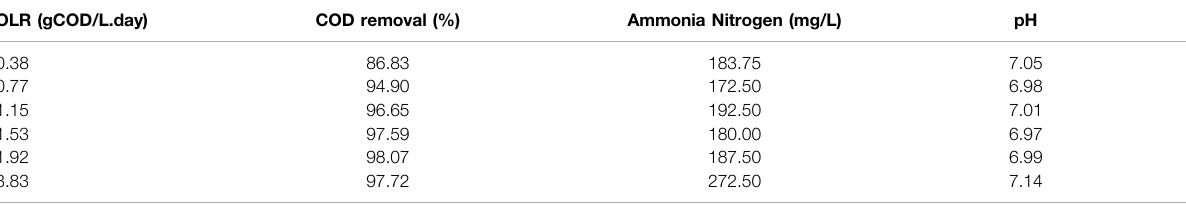
TABLE 5 | Monitoring parameters in the BMP test. OLR (gCOD/L.day)